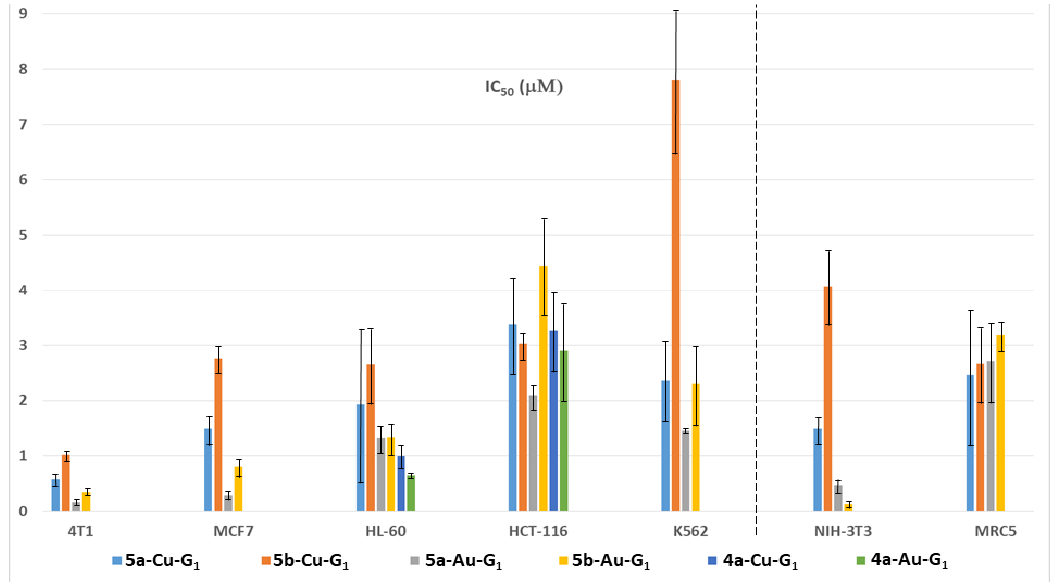
Figure 9. IC 50 s of four off-center dendrimers (series 5) and two dendrimers (series 4) towards five cancerous cell lines and two non-cancerous (NIH-3T3 and MRC5).